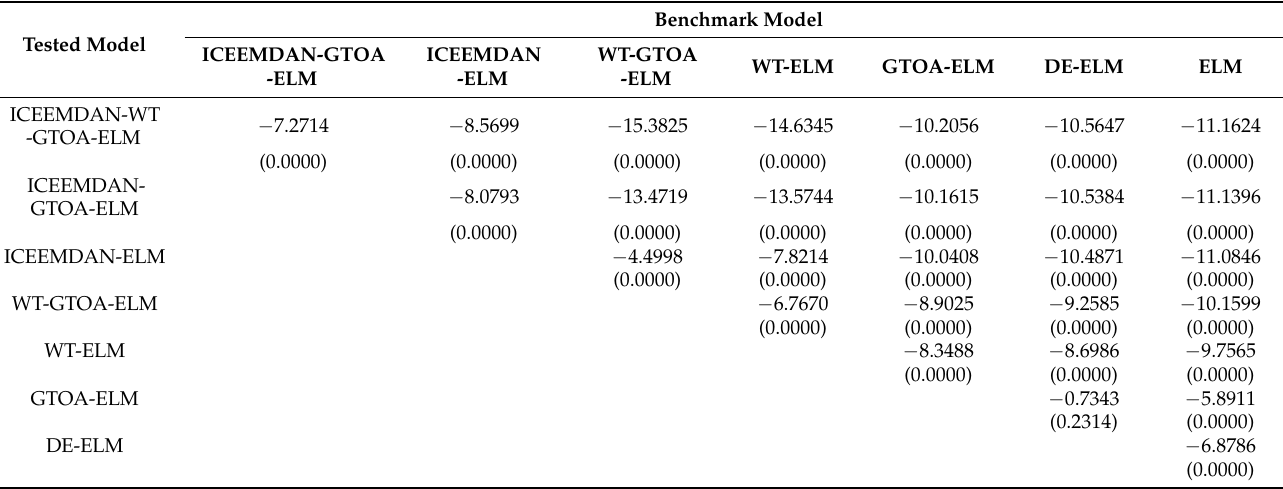
Table 6. DM test results of two-step ahead forecasting of